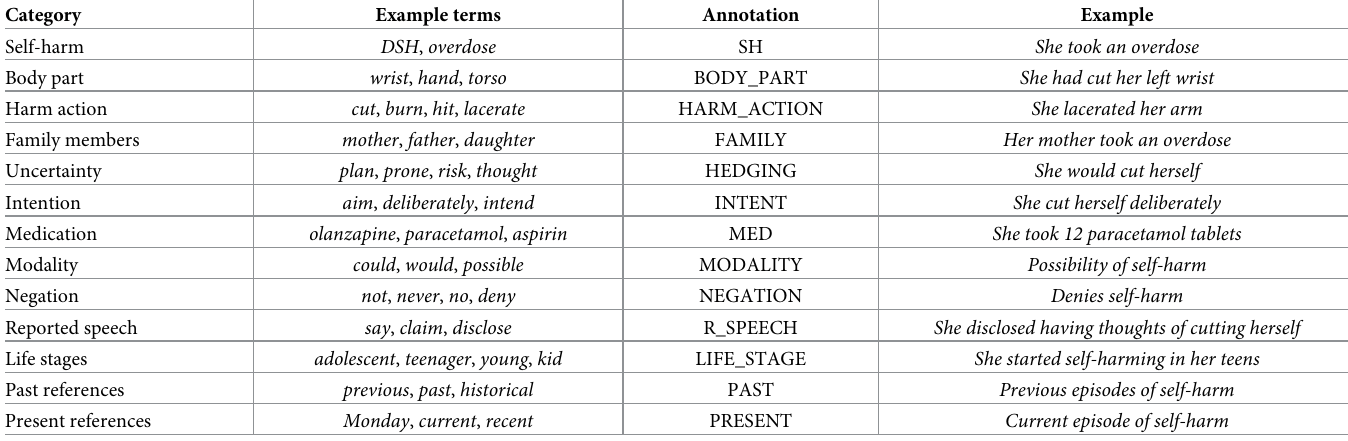
Table 1. Lexicons used for tagging of semantic